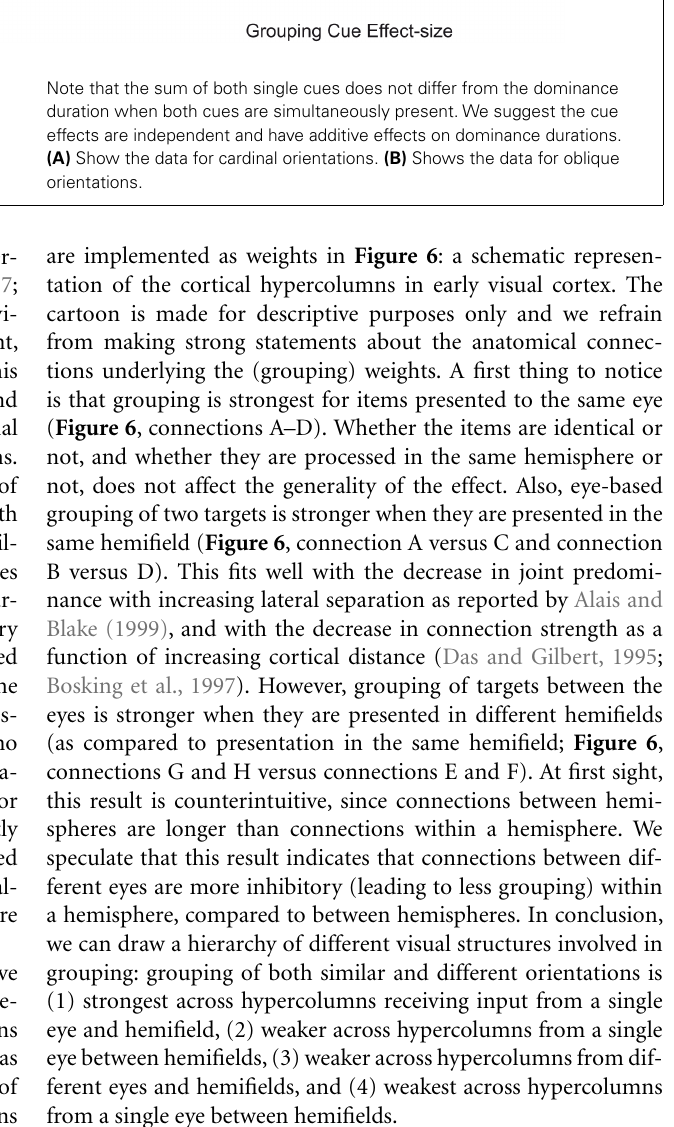
Note that the sum of both single cues does not differ from the dominance duration when both cues are simultaneously present.We suggest the cue effects are independent and have additive effects on dominance durations. (A) Show the data for cardinal orientations. (B) Shows the data for oblique